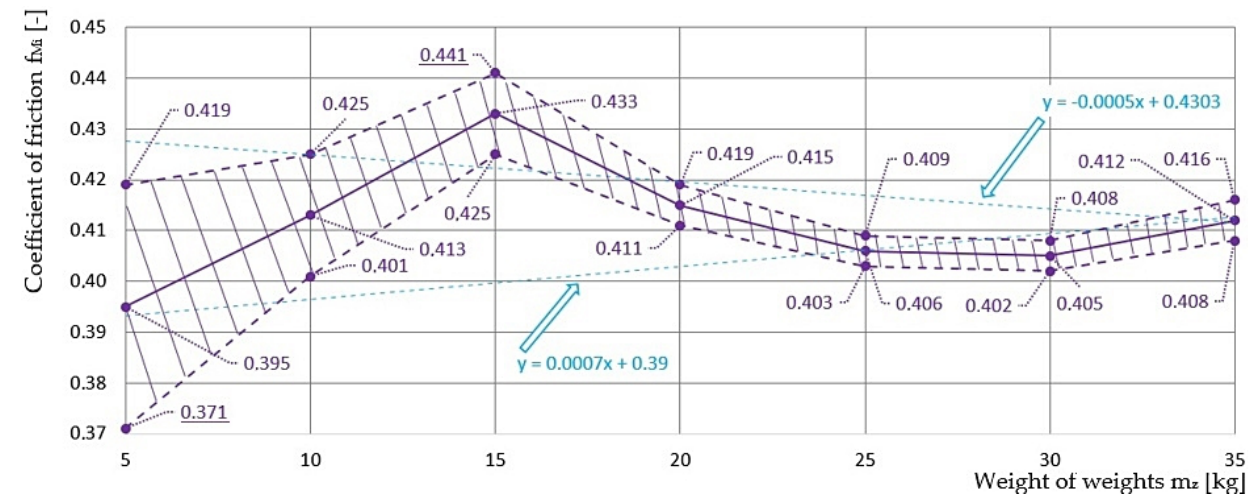
Figure 3. Experimentally determined friction coefficient values, 8 mm diameter cable, dry and clean groove surface.